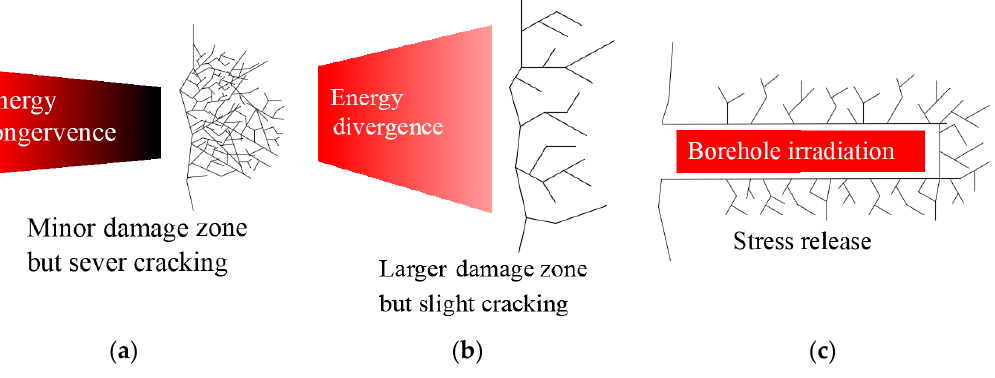
Figure 10. The effect of microwaves fracturing rocks. ( a ) Convergent waveguide irradiation; ( b ) horn waveguide irradiation; ( c ) borehole irradiation.